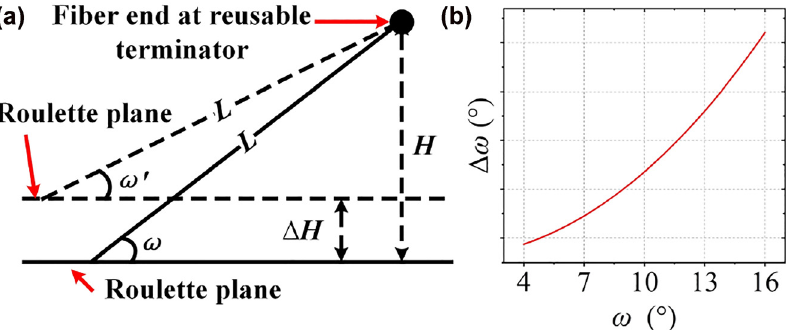
Figure 8: Model for the machining error analysis and the corresponding results: (a) Model for analyzing the influence of machining error. The horizontal solid and dashed lines are the relative positions of the fiber and the roulette before and after the roulette plane is raised. The oblique lines represent the fiber; (b) Relationship between grinding angle error 𝛥𝜔 and grinding angle 𝜔 .